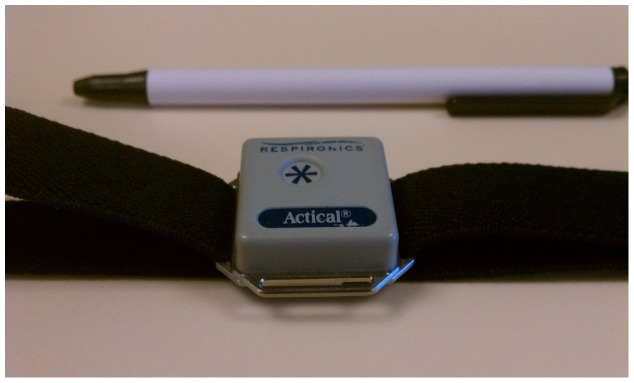
Accelerometer image.